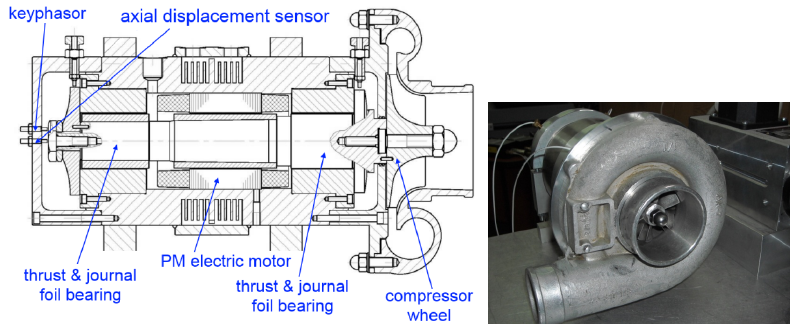
Figure 2: Cross–sectional view of the compressor supported on foil bearings [10].